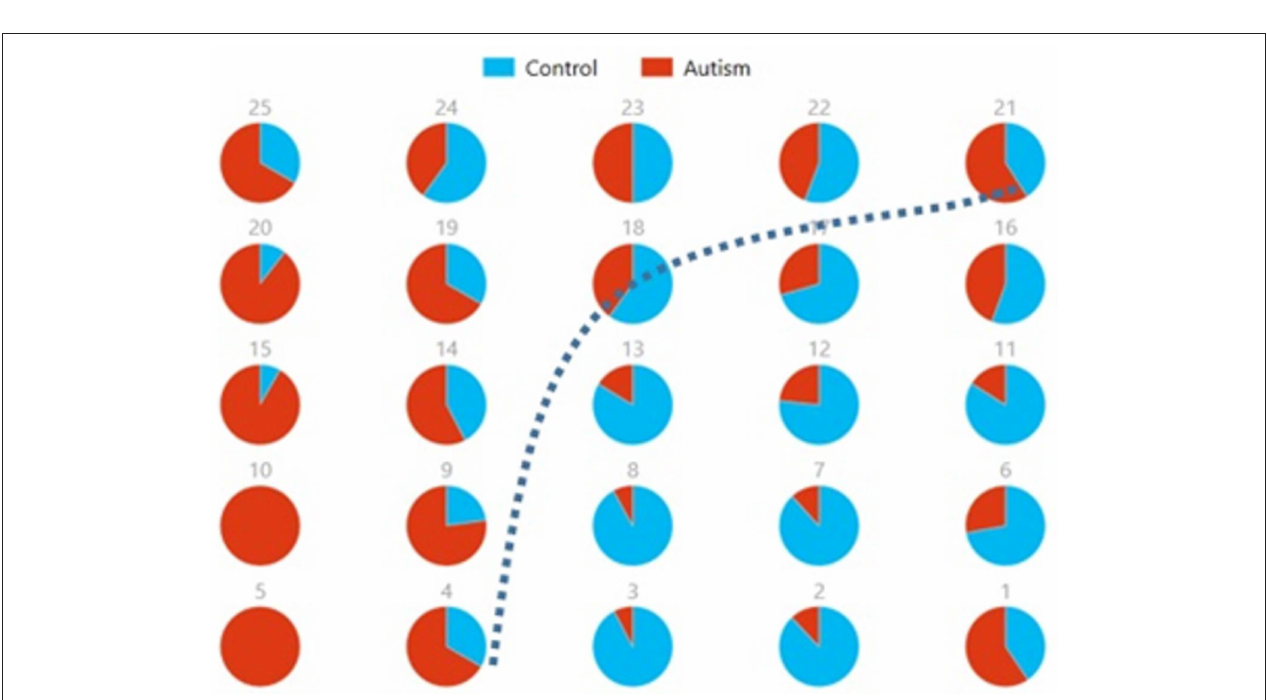
FIGURE 12 | This figure represents the spatial map for C x a , the group-level component in the Control group with the highest spatial correlation with A x .